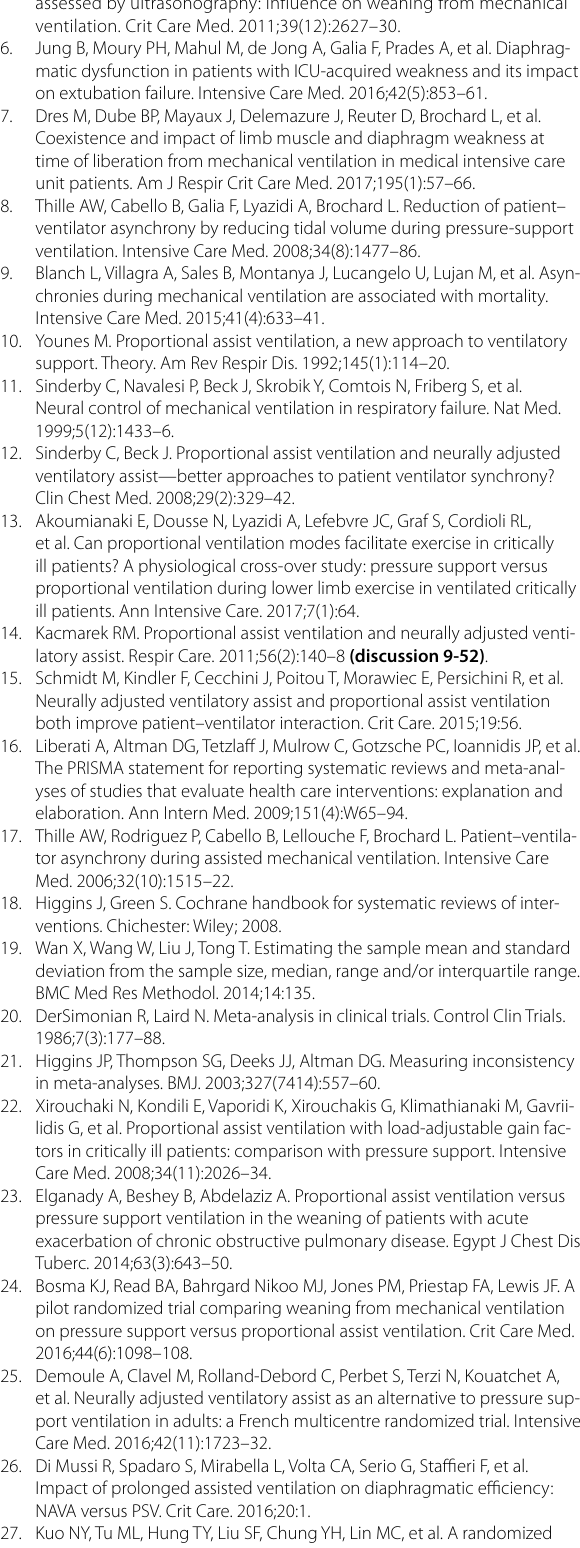
Additional file 2: Table S2. Full text articles excluded. Additional file 3: Table S3. Sensitivity analyses of primary